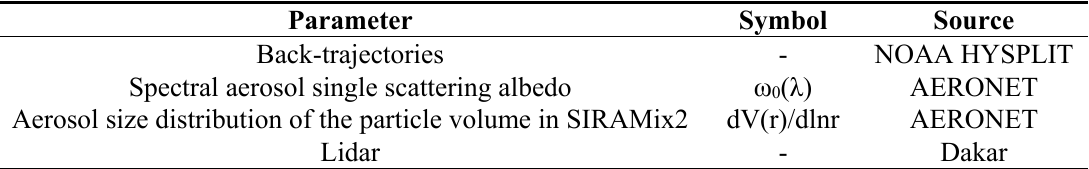
Table 5. Data used in the present study for the determination of predominant aerosol types.